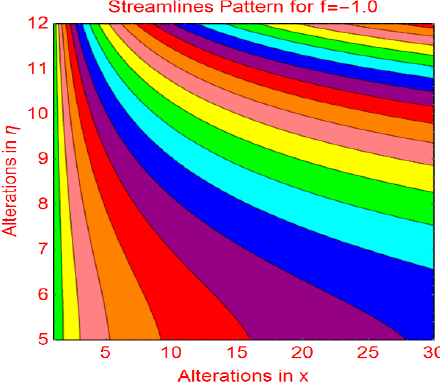
Figure 9. Streamlines profile for ( a ) f 1 = 0.0 and ( b ) f 1 = 1.0. Molecules 2020 , 25 , x FOR PEER REVIEW